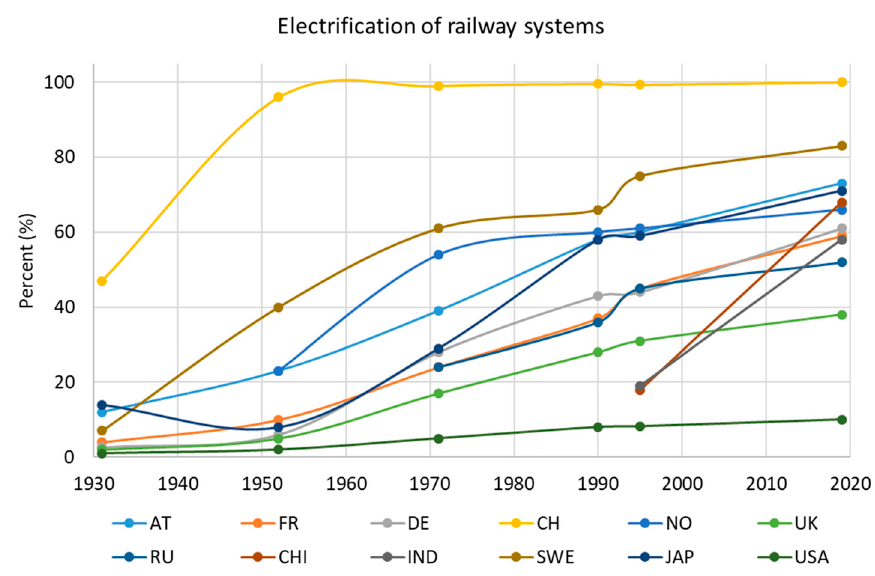
Figure 5. The electrification of railways in several countries, 1930 to 2019.